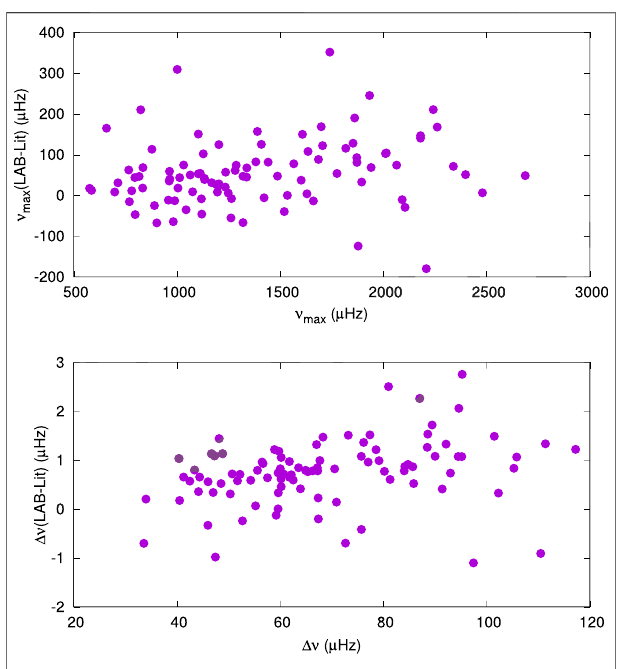
FIGURE 4 | Comparison of ] max (top panel) and Δ ] (bottom panel) obtained in this paper with those in the literature.